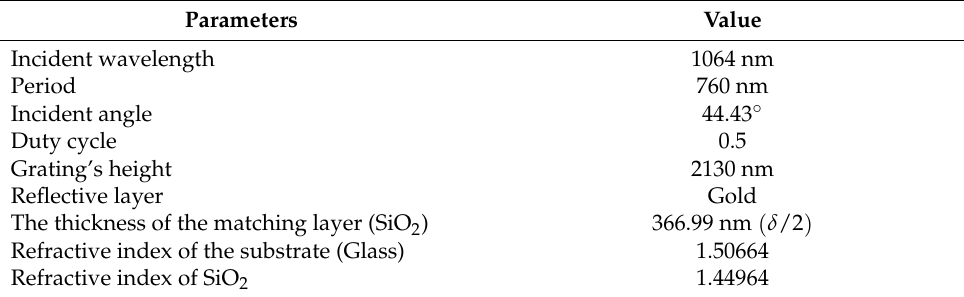
Table 1. Rectangular shaped grating